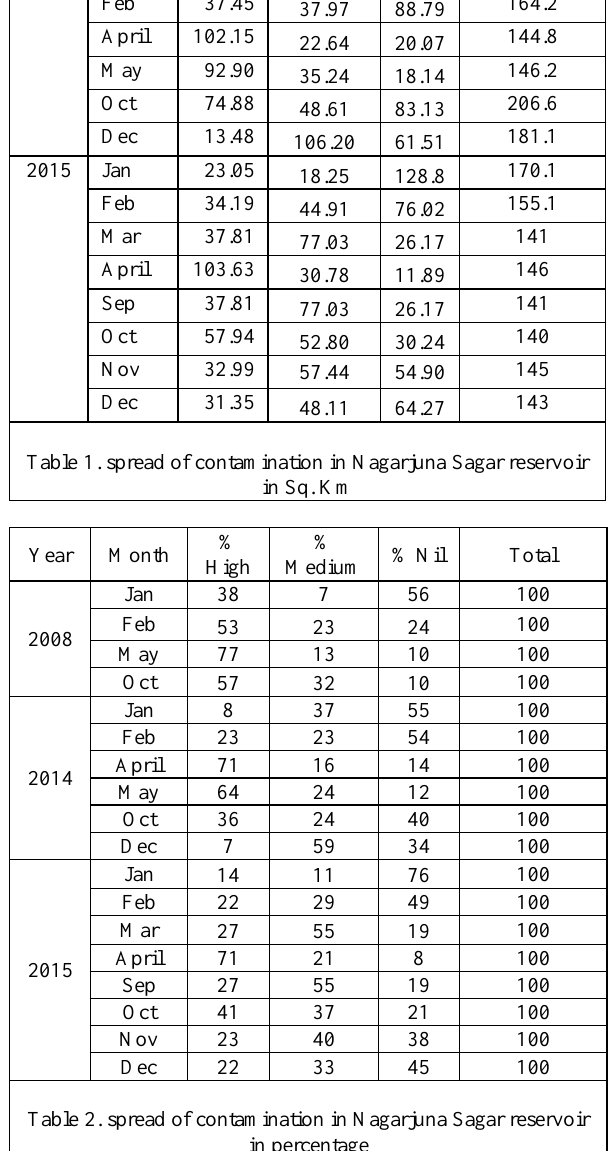
Table 2. spread of contamination in Nagarjuna Sagar reservoir in percentage